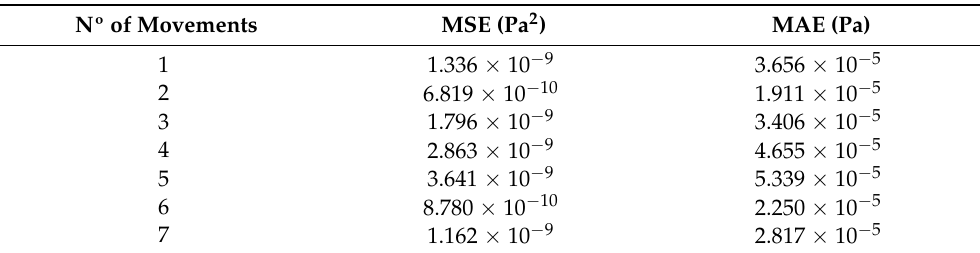
Table 4. Error of movement estimation for sectorization 2: dam and foundation divided into riverbed and